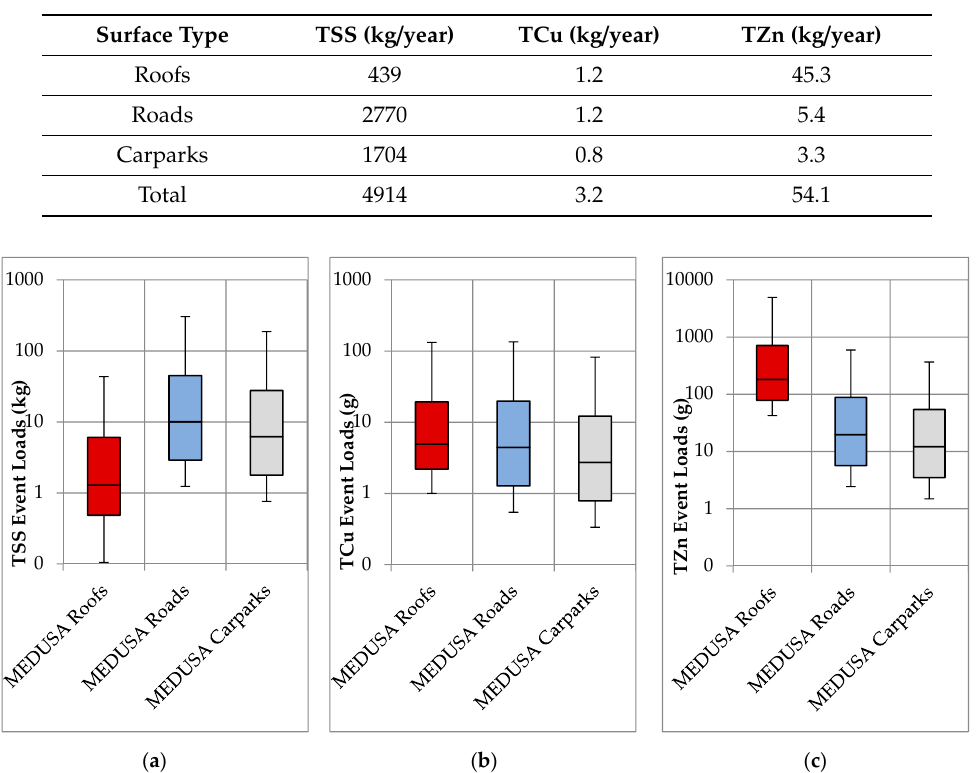
Figure 7. Event load variation across the 88 modelled events of 2012, by surface type, for ( a ) TSS, ( b ) total copper, and ( c ) total zinc.